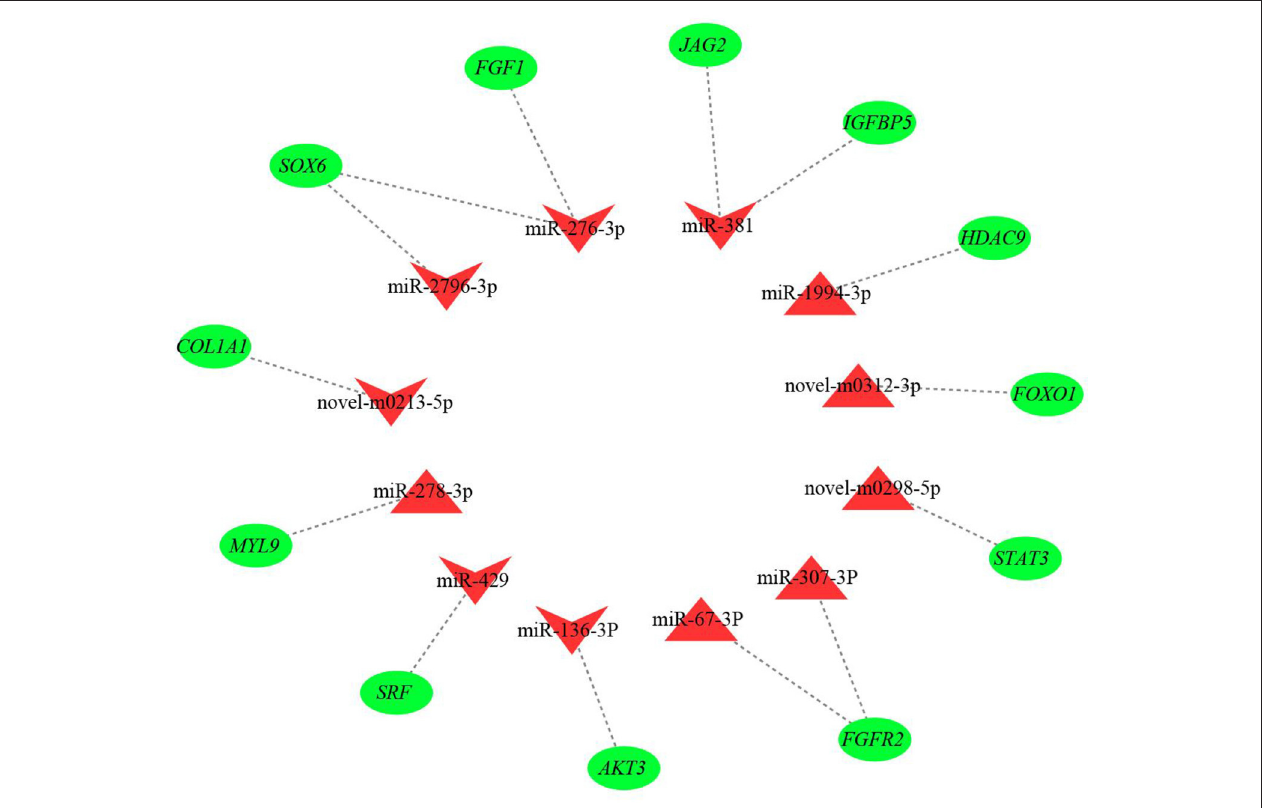
FIGURE 5 | The miRNA-mRNA interaction network of 12 differentially expressed miRNAs and their target genes. The red triangles and inverted triangles represent up-regulated and down-regulated miRNAs in Longissimus dorsi muscle of Liaoning cashmere (LC) goats compared to Ziwuling black (ZB) goats, respectively. The green circles represent the target genes of the